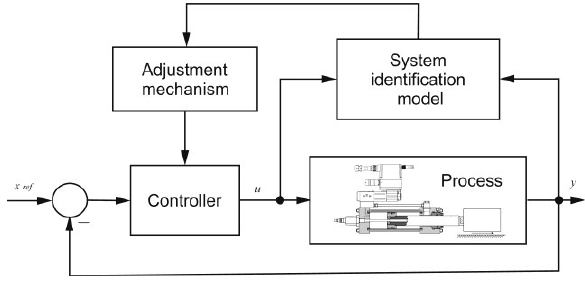
Fig. 1. Model Identification Adaptive Control